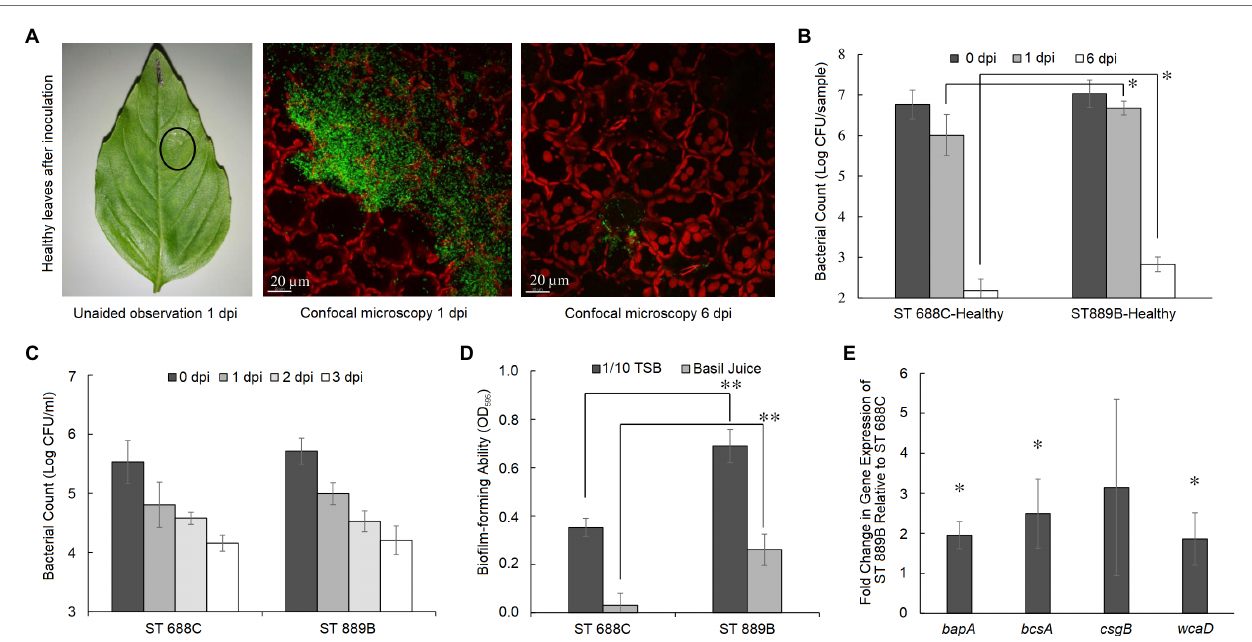
FIGURE 2 | (A) A representative healthy-looking basil leaf as seen unaided at 1 dpi, and under confocal microscopy at 1 and 6 dpi (from left to right) where red signals represent leaf cells while green signal represents GFP-tagged Salmonella cells; (B) bacterial counts of ST 688C and ST 889B on healthy-looking leaf tissue at 0, 1, and 6 dpi; and (C) in sterile basil juice at 0, 1, 2, and 3 dpi; (D) biofilm forming ability of ST 688C and ST 889B in 1/10 TSB and sterile basil juice; (E) fold change in gene expression of biofilm formation genes in ST 889B relative to ST 688C. Values linked by lines and denoted by * and ** represent significant difference at p < 0.05 and < 0.01, respectively, except in (E) , where * denotes significant difference ( p < 0.05) to a theoretical mean of 1, which is the relative gene expression level of ST 688C. Bacterial counts in (B,C) were the average of three experiments, while that of biofilm forming ability in (D) and fold change in gene expression in (E) were the average of two experiments. Error bars denote standard